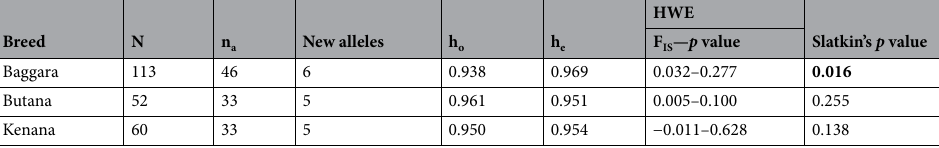
Table 2. Number of alleles (n a ) and new alleles, observed (h o ) and expected (h e ) heterozygosity, Hardy Weinberg equilibrium (HWE) measured through F IS and Slatkin’s exact test in the cattle breeds studied. N = sample